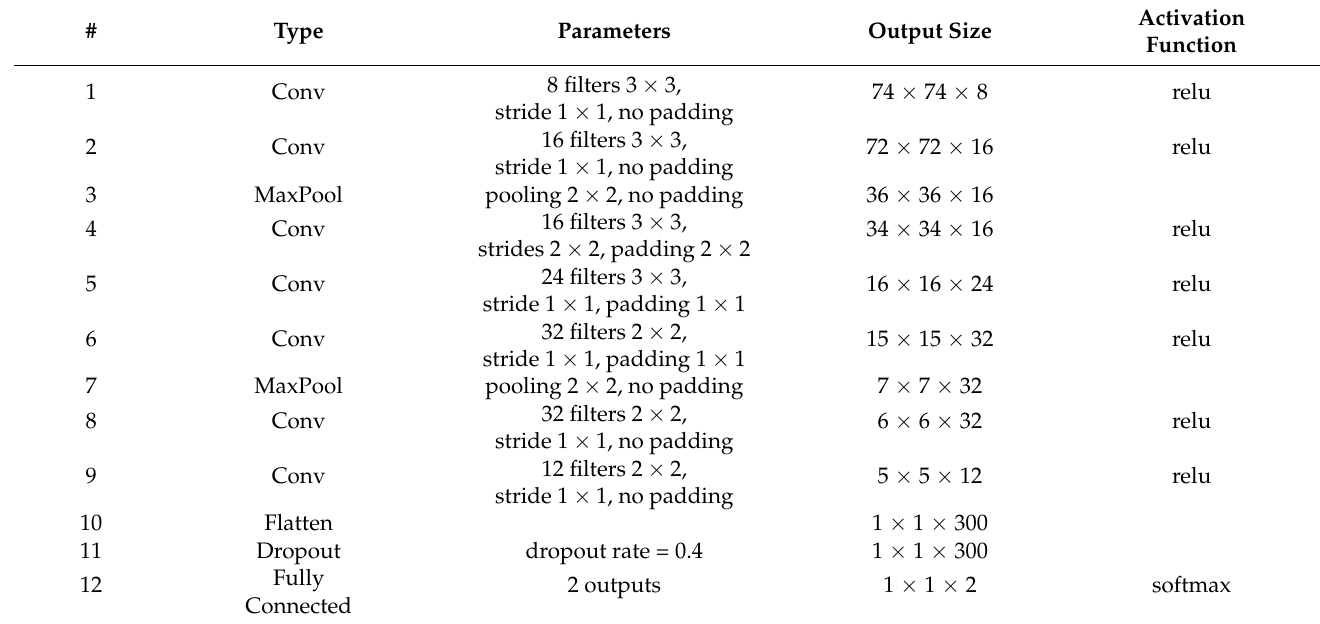
Table 6. CNN-based unlaminated color copy detector architecture (layers).